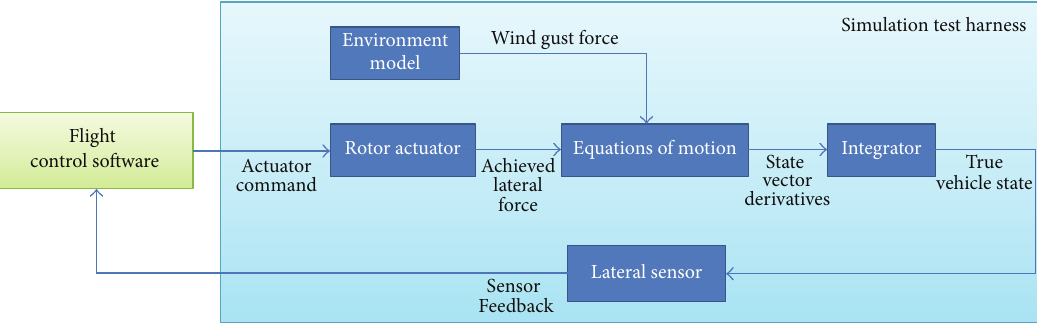
Figure 6: Block diagram of the UAV Simulation Test